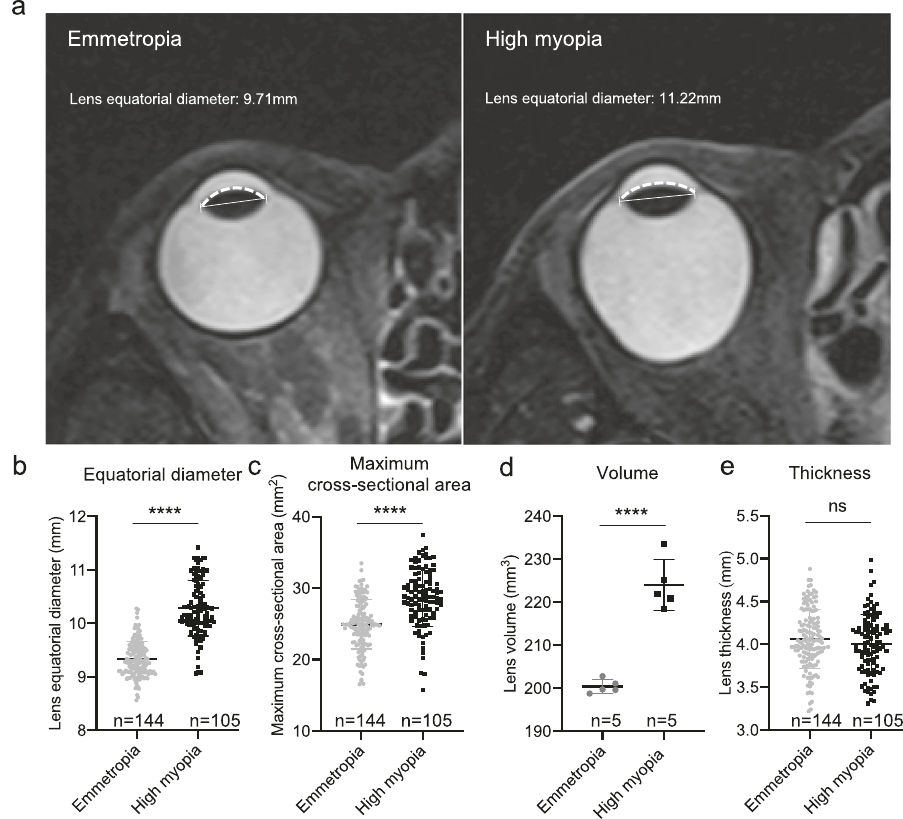
Fig. 1 Pathological lens growth was identi fi ed in human with high myopia. a Representative magnetic resonance imaging of an emmetropic control eye and a highly myopic eye. The capped lines represent the equatorial diameter of lens. The dotted curves represent the anterior surface of lens showing an obviously fl atter lens in highly myopic eyes. b Lens equatorial diameter ( n = 144 in emmetropic group vs. 105 in highly myopic group, p = 1.39e − 45). c Maximum cross-sectional area of lens ( n = 144 in emmetropic group vs. 105 in highly myopic group, p = 7.35e − 14). d Lens volume ( n = 5 in emmetropic group vs. 5 in highly myopic group, p = 2.42e − 5). e Lens thickness ( n = 144 in emmetropic group vs. 105 in highly myopic group, p = 0.208). Results are expressed as mean ± SD. Level of signi fi cance was detected using two-sided Student ’ s t test ( b – e ). **** p < 0.0001 and ns represents no signi fi cant difference. Source data are provided as a Source Data fi